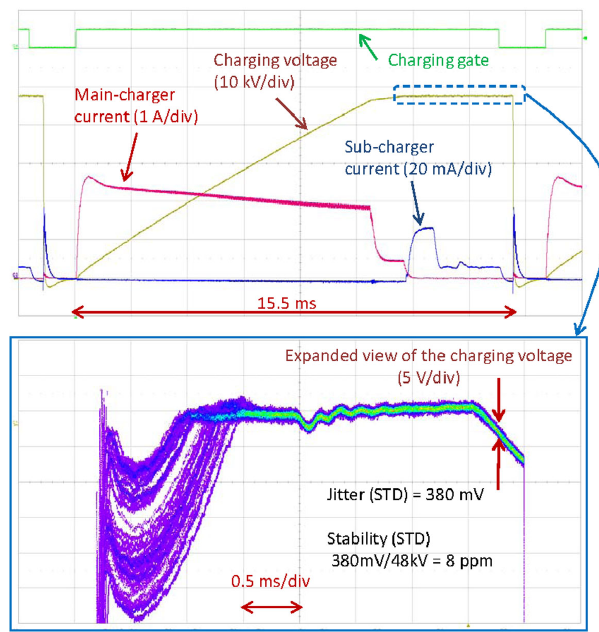
FIG. 13. Typical waveform during the PFN charging sequence. The bottom figure shows the expanded flat part of the charging voltage where 20 waveforms are overlaid to indicate the voltage stability.